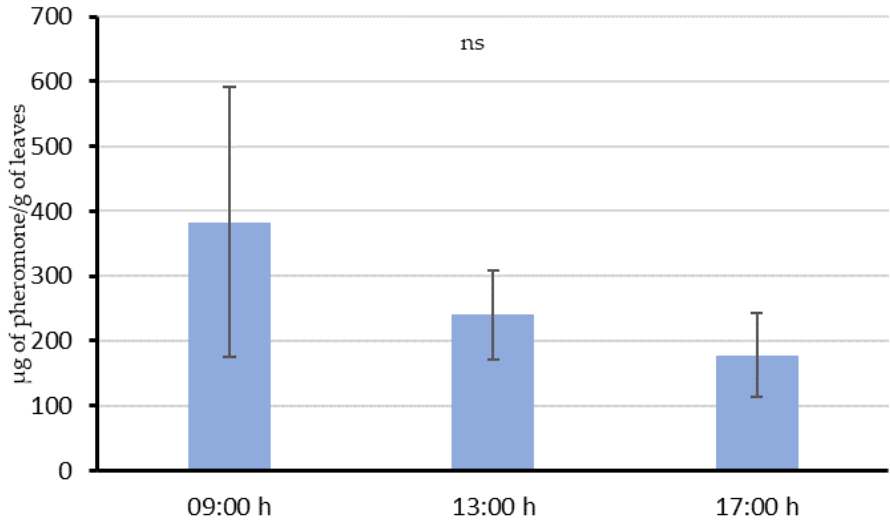
Figure 3. Mean (± SE) quantity of pheromone (µg pheromone/g leaves) adsorbed on leaf samples of Experiment 2, after overnight aerosol shooting (from 18:00 to 6:00). Bars labeled with different letters are significantly different, ANOVA followed by the Fisher LSD test (F = 0.560; df = 2, 13; p > 0.05).